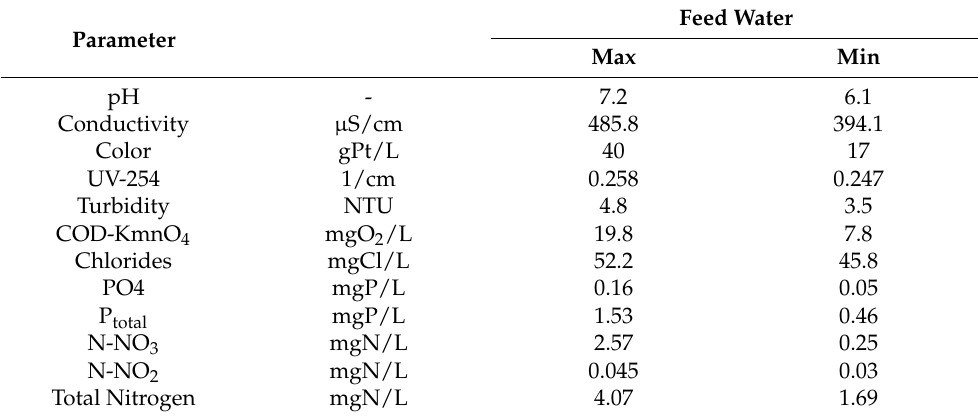
Table 1. Ranges of parameters of raw water